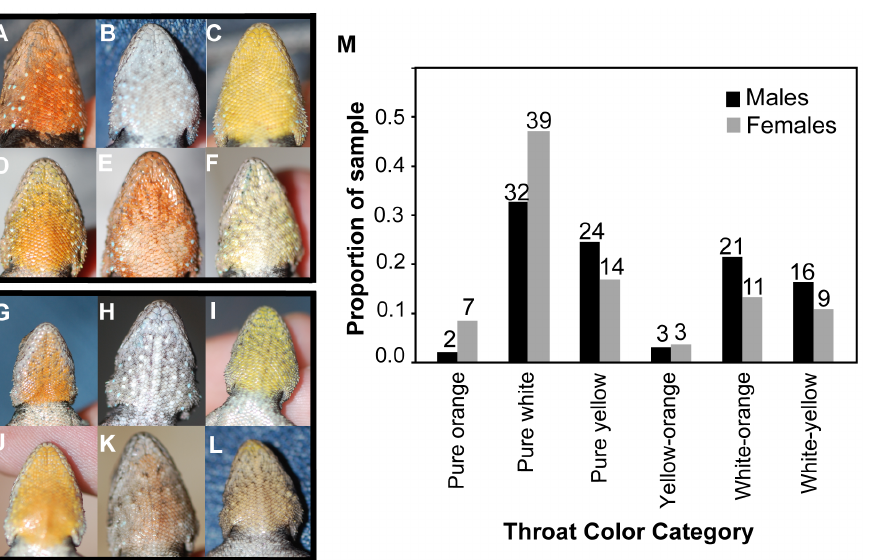
Figure 2. Male and female throat color morphs present in S.grammicus at SAA. A–F: Male morphs. A. Pure orange. B. Pure White. C. Pure yellow. D. Yellow-orange. E. White-orange. F. White-yellow. G–L: Female morphs. G. Pure orange. H. Pure white. I. Pure yellow. J. Yellow-orange. K. White-orange. L. White-yellow. M. Frequencies of male and female throat color morphs among all lizards captured at SAA in 2011. Sample sizes above bars.